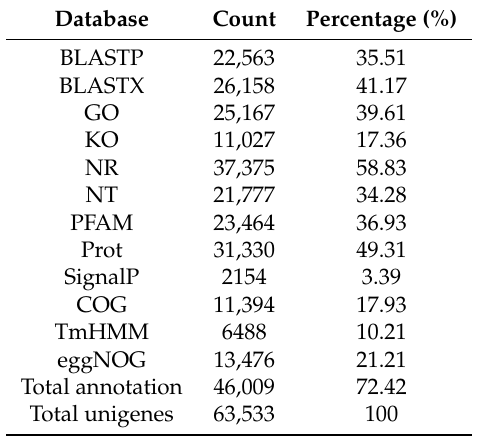
Table 1. Summary of unigenes